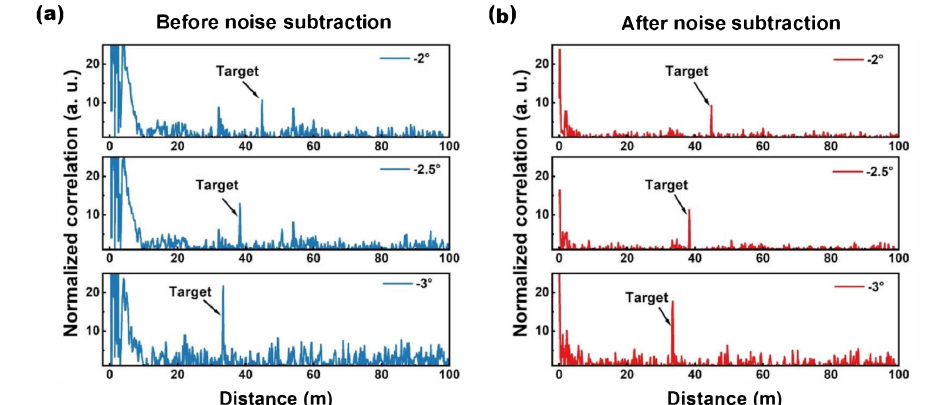
Figure 9. Normalized correlation ( a ) before noise subtraction and ( b ) after noise subtraction The normalized correlation is obtained in directions of − 2 ◦ , − 2.5 ◦ , − 3 ◦ ,